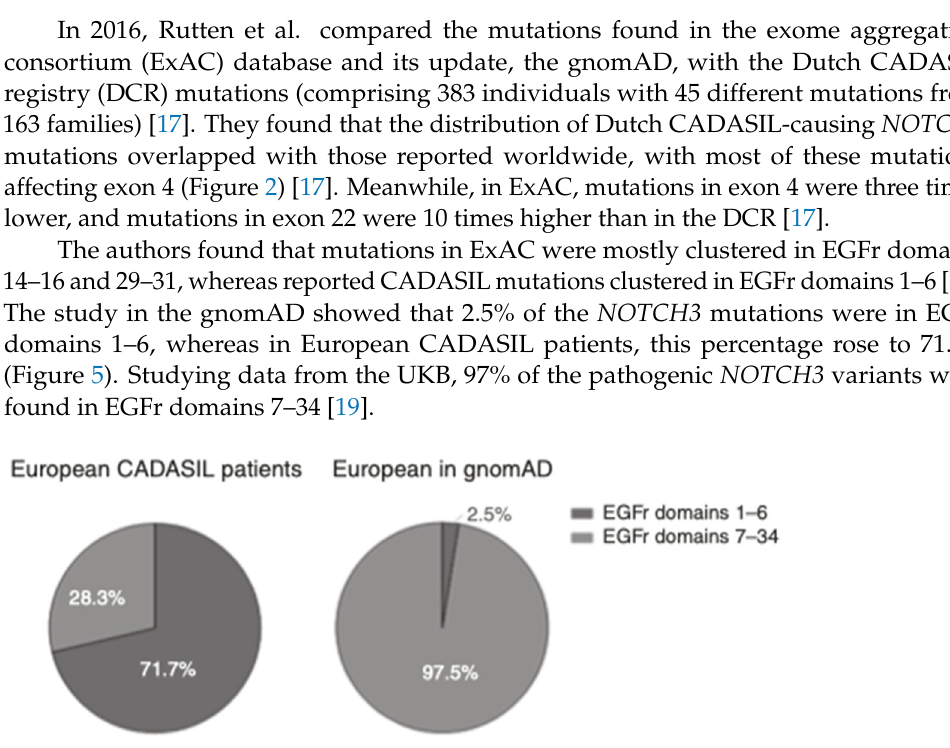
Figure 5. Location of NOTCH3 mutations in European CADASIL patients versus gnomAD database individuals. Figure extracted from Rutten et al. (2018) [18].